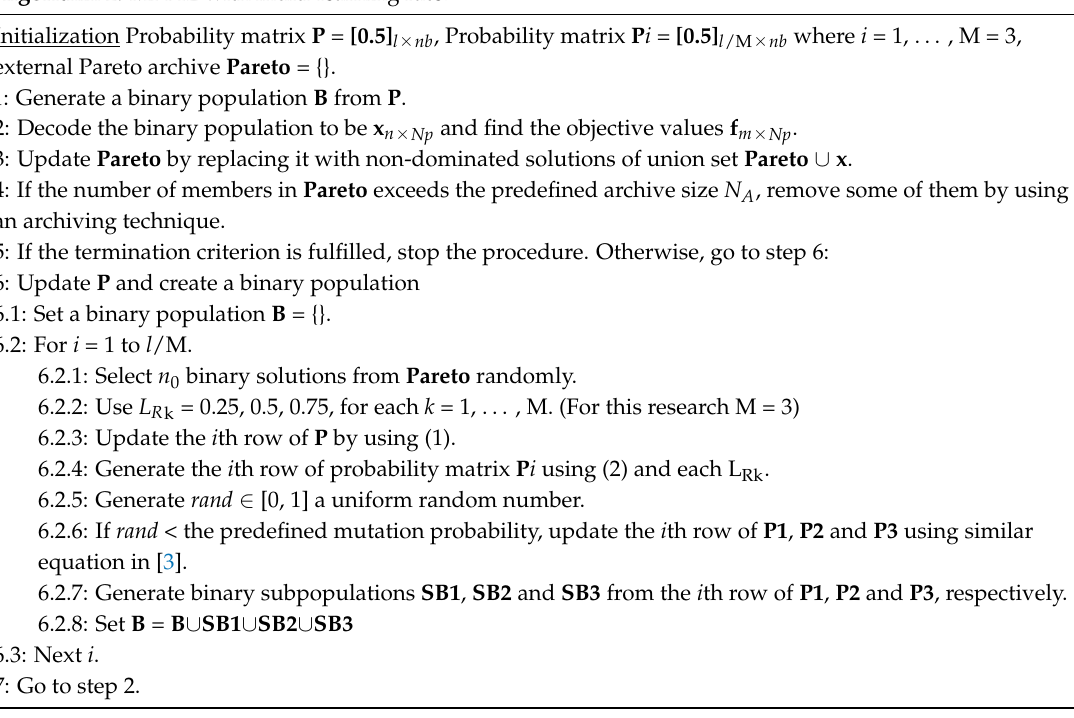
Algorithm 2. MPBIL with multi-learning